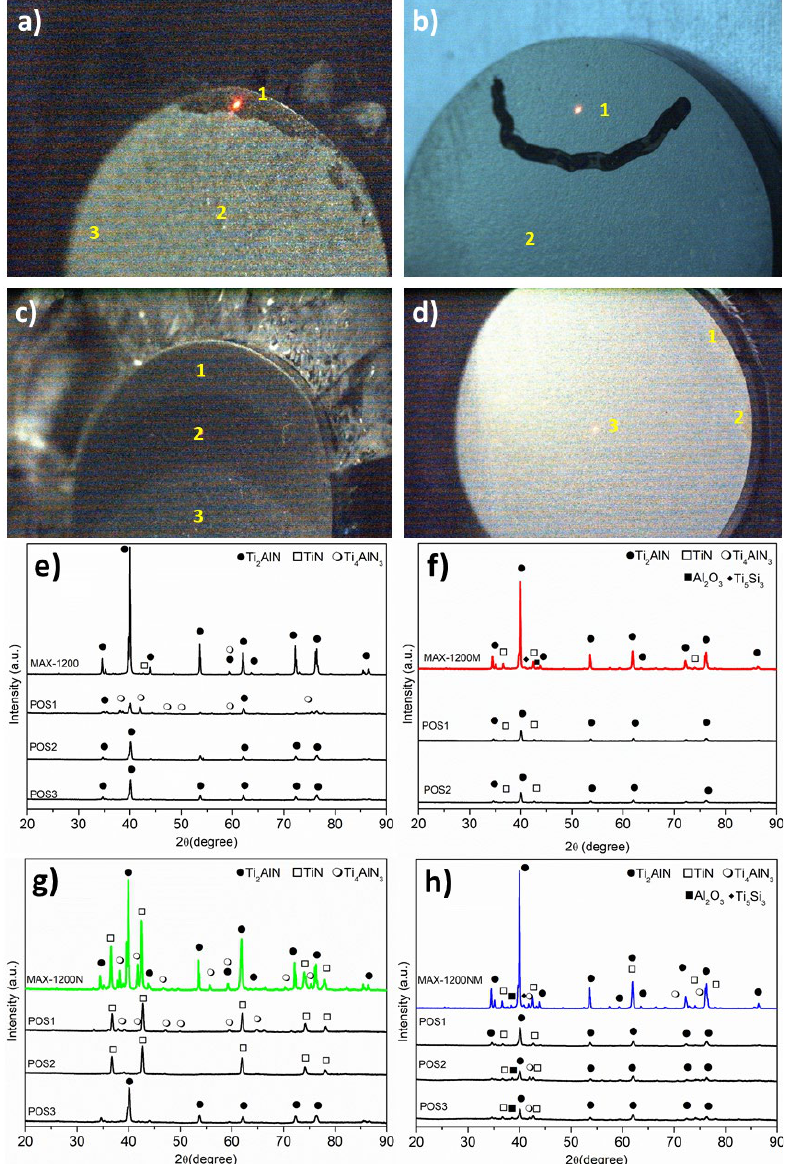
Figure 3. Macroscopic view of the samples and their micro-XRD results for: ( a , e ) MAX-1200, ( b , f ) MAX-1200M, ( c , g ) MAX-1200N, and ( d , h ) MAX-1200NM.